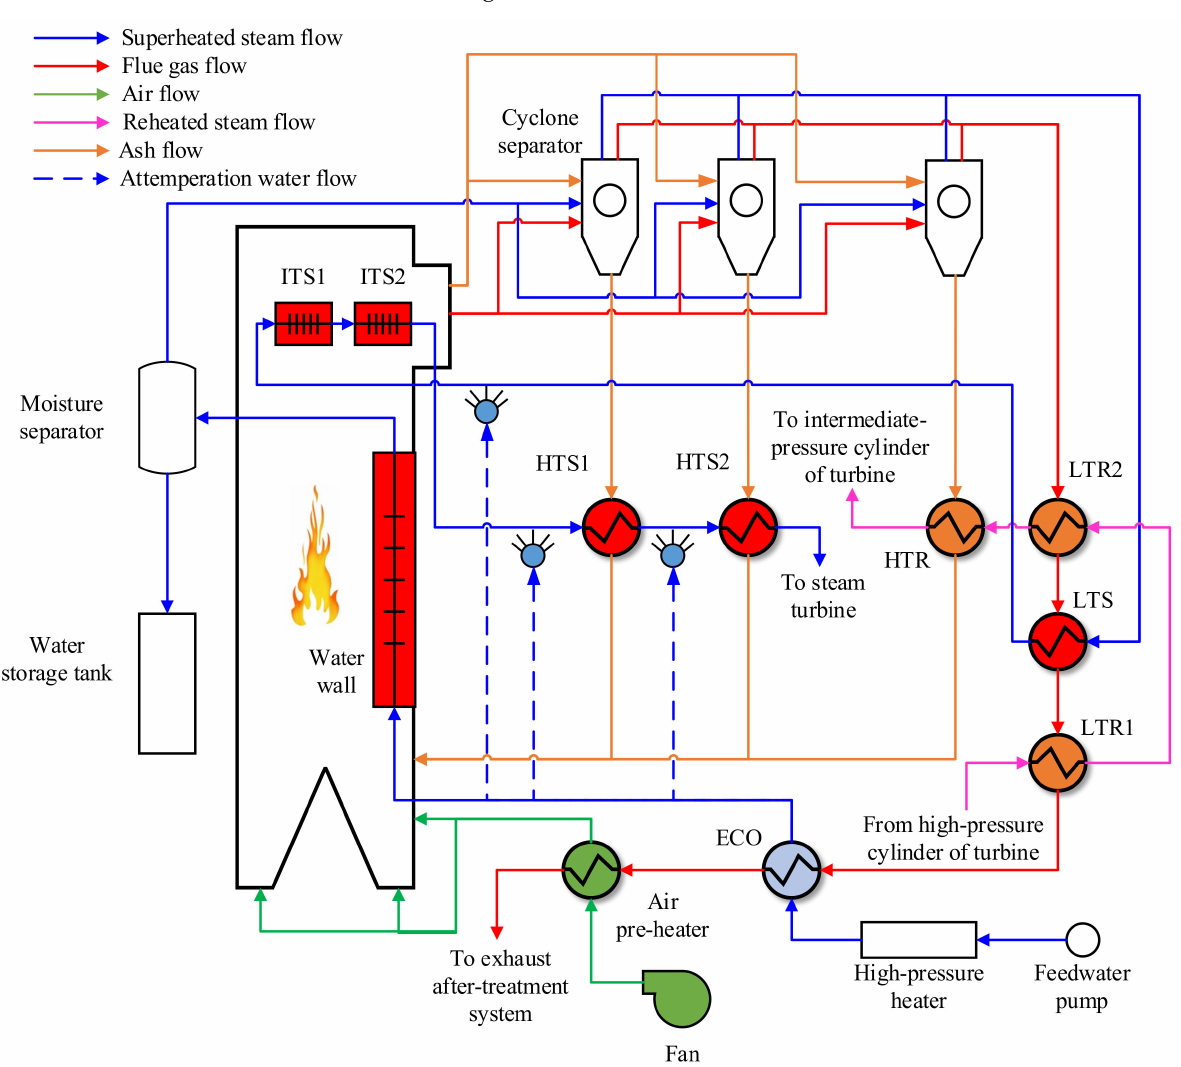
Figure A1. Schematic of the coupled water-steam, air-flue gas and ash system of the CFB